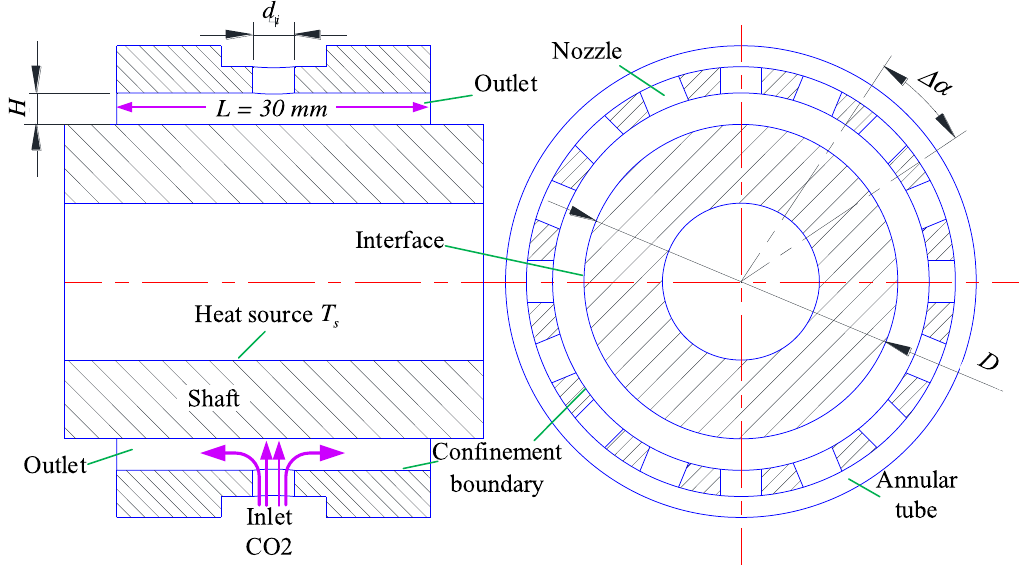
Fig. 2. Schematic of considered cooler geometry (with shaft). Table 1. Boundary conditions for the numerical